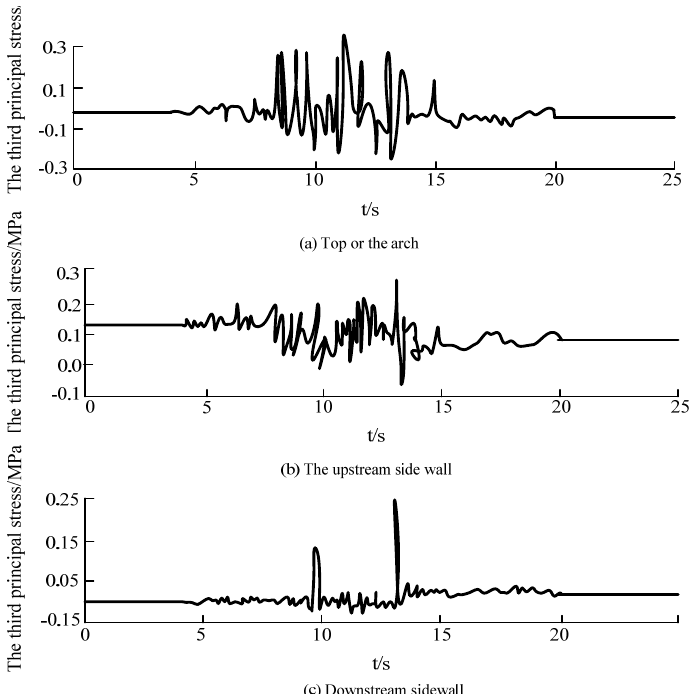
Figure 5: Time-history curves of 3rd principal stress at typical area of surrounding rock.